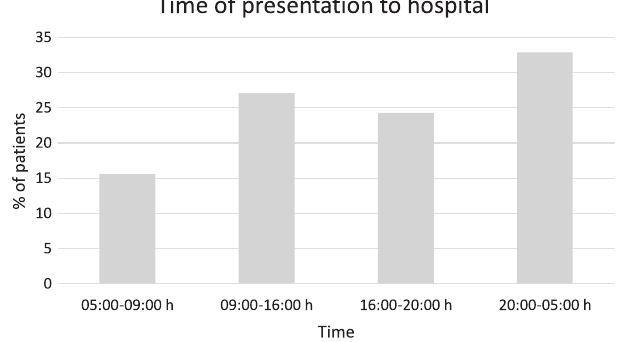
Figure 3. Time of presentation to hospital. Presentation of data showing the percentage (%) number of patients presenting during each time period throughout the day. Most patients presented during the night to early morning (20:00 – 05:00 h) 32.9%, fewest patients during morning commute 15.6%.